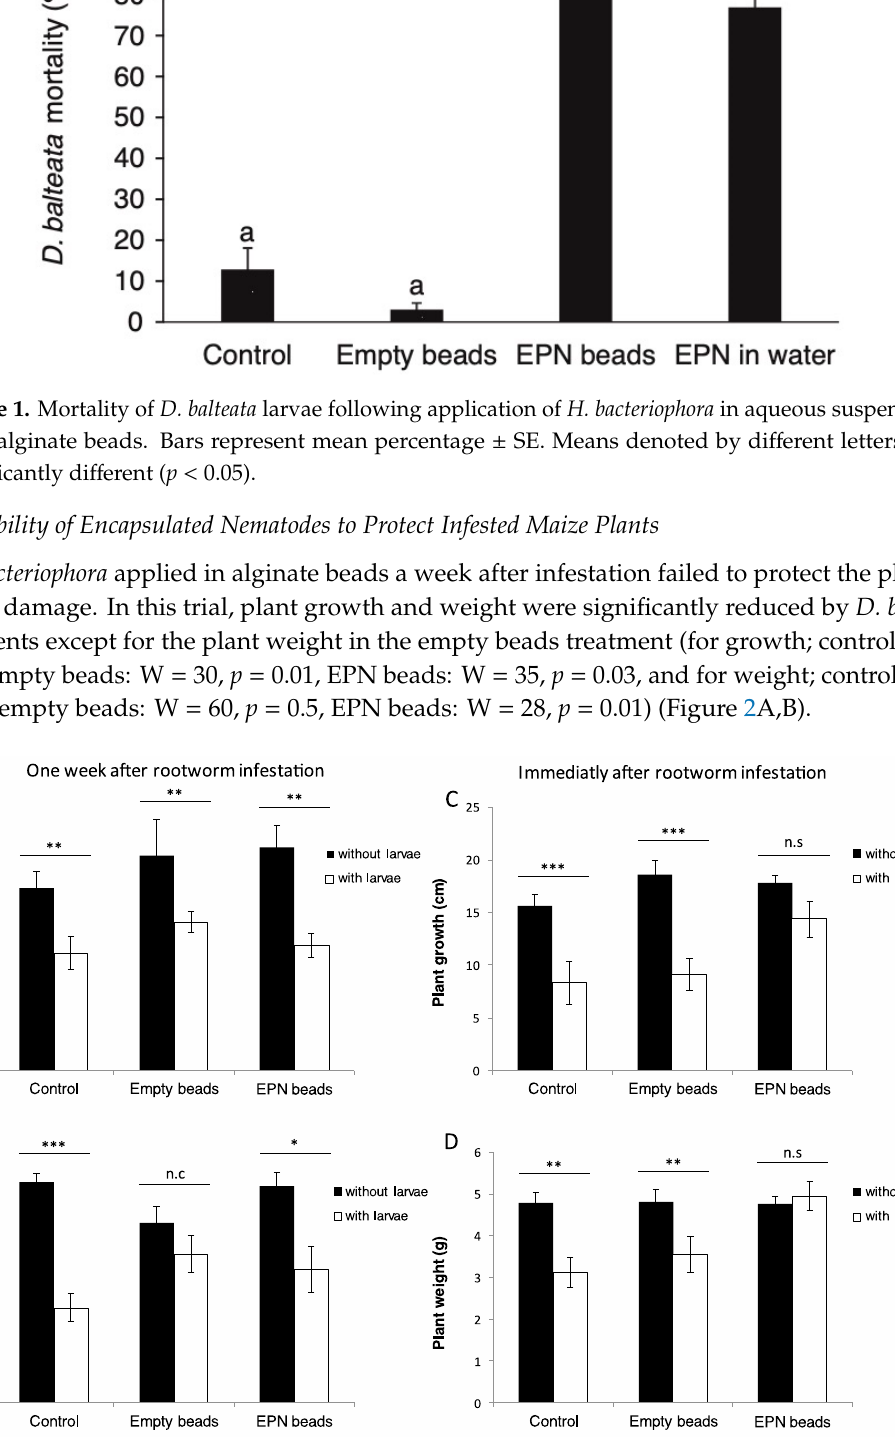
Figure 2. Increase in size ( A , C ) and fresh weight ( B , D ) (mean ± SE) of maize plants infested or